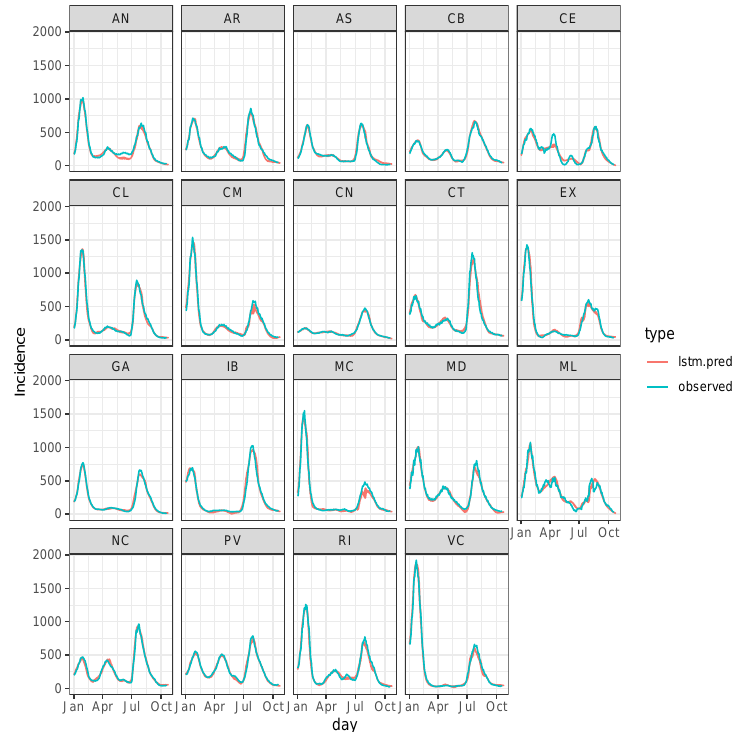
Figure 3. Predicted (cid:98) y ts and observed daily incidence over 2021